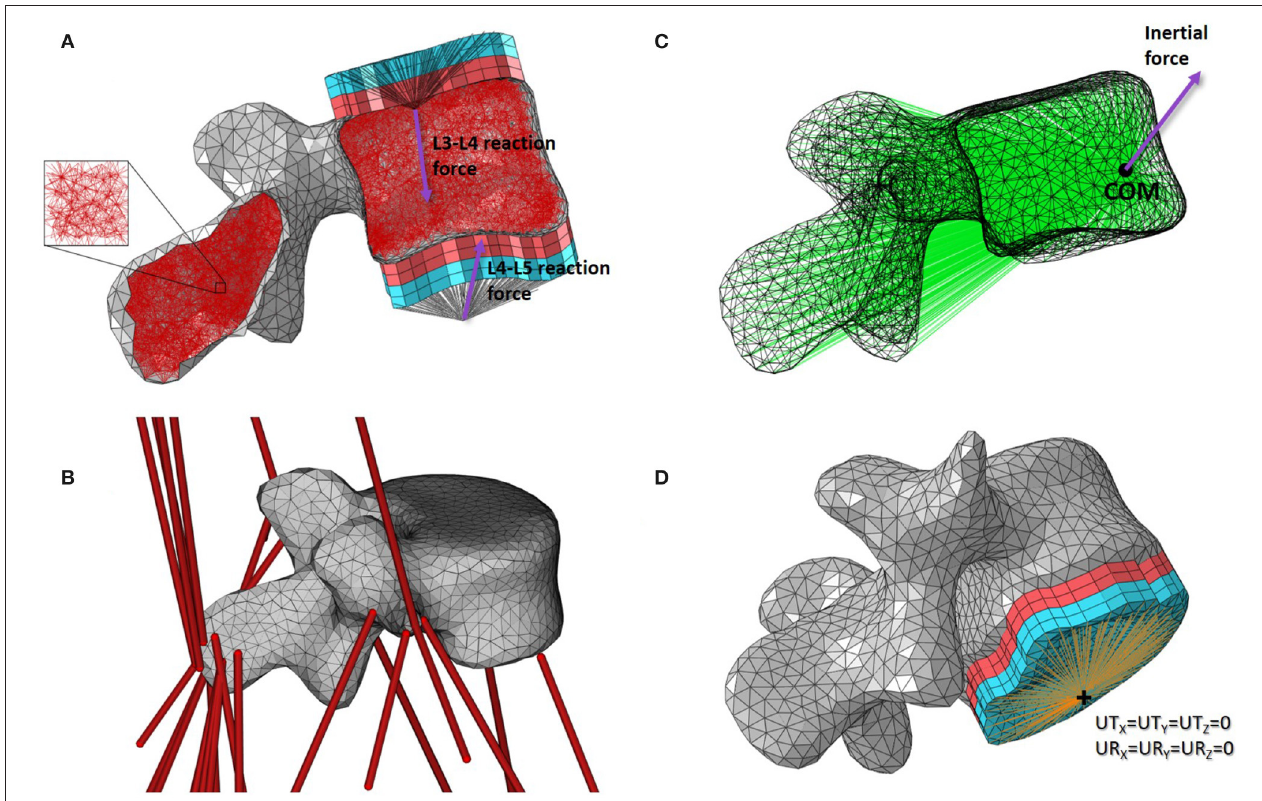
FIGURE 2 | Base mesoscale structural model of L4. (A) Side cut with load applicators. (B) 3D view with musculotendon actuators from the musculoskeletal model. (C) Side view with inertial load applicator. (D) 3D view with boundary condition. Cortical shell elements are shown in grey and trabecular truss elements in dark red. Wedge elements of the softer layers of the load applicators are shown in light red while the stiffer layers elements are in light blue. Truss elements connecting the nodes on the external layers of the load applicators to the joint centres where the joint reaction force is applied are shown in black. Truss elements of the inertia applicator connecting the nodes of the cortical elements to the centre of mass (COM) of the lumbar segment where the inertial force is applied are shown in green. Beam elements connecting the nodes on the external layer of the load applicator to the duplicate node at the joint centre for the boundary condition are shown in